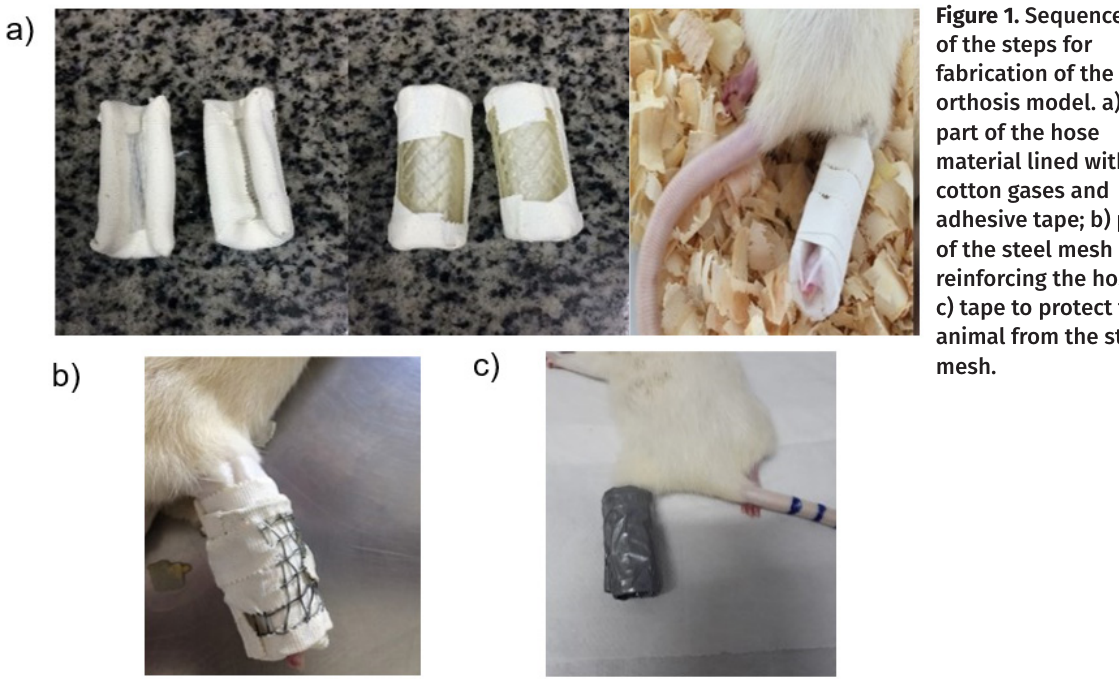
the movements of plantar flexion and ankle dorsiflexion to verify the presence of muscle